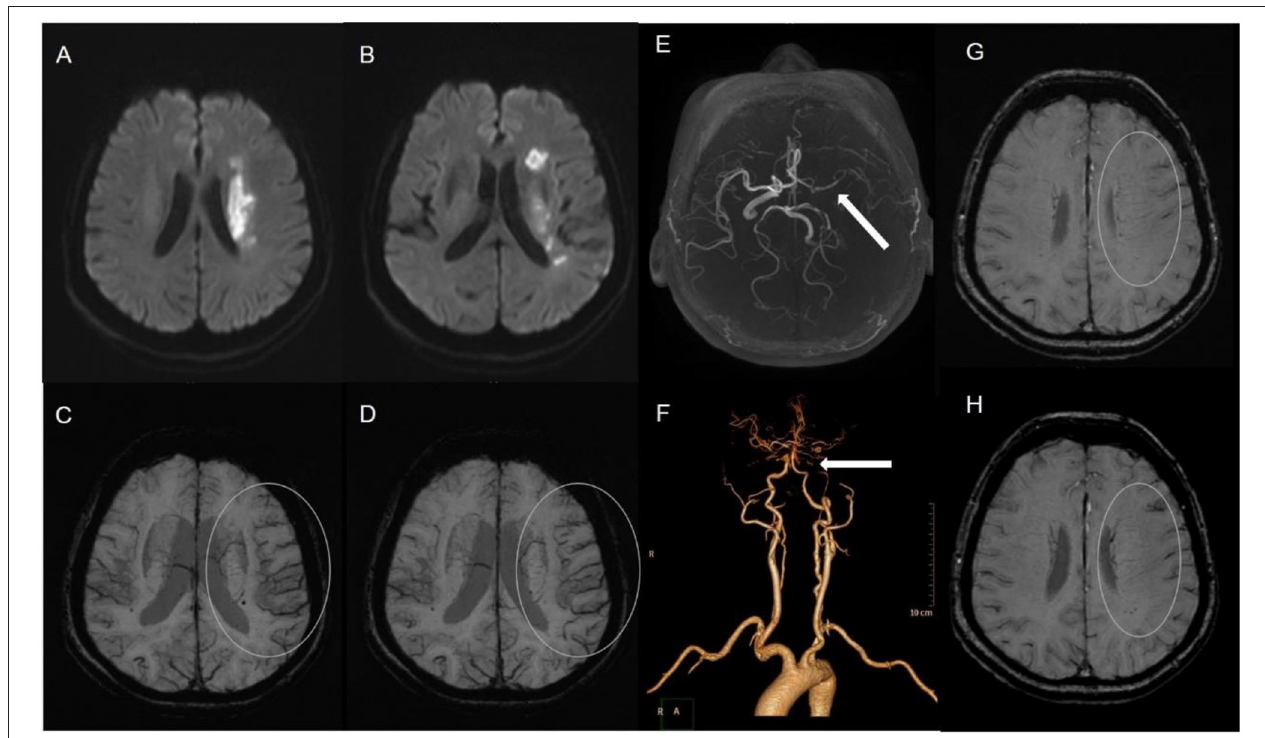
FIGURE 1 | A 62-female patient with left CWI (A,B) . SWI indicates significantly more and larger vessels with a greater signal loss (APCV) in the left hemisphere [ (C,D) white circle]. CTA showed left internal carotid artery occlusion [ (F) white arrow]. The status of cerebral arterial circle was graded as good with the presence of contrast filling from the M1 to M3 of MCA and anterior cerebral artery [ (E) white arrow]. The SWI showed prominent medullary veins hypointense signals (APMV) in the left hemisphere [ (G,H) white